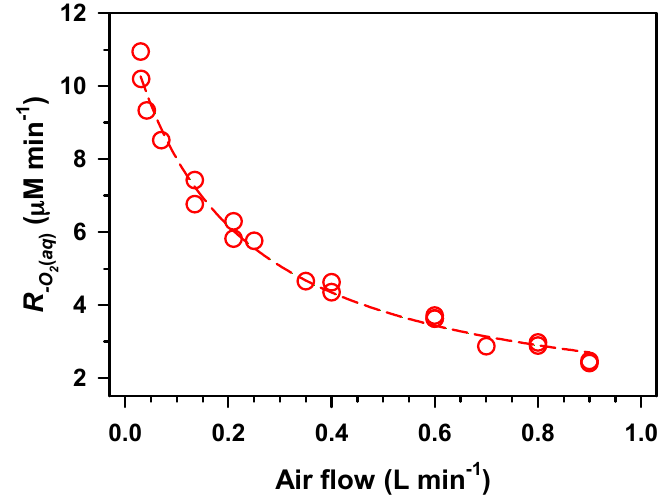
Figure 3. Rate of dissolved oxygen decay ( R − O 2 ( aq ) ) vs variable air flows. Experimental conditions: [PA] 0 = 20.0 mM at pH 1.0 and 25 ◦ C irradiated at λ ≥ 305 nm ( I a = 1.02 × 10 − 5 Einstein L − 1 s − 1 ). Represented reaction rates are multiplied by − 1.